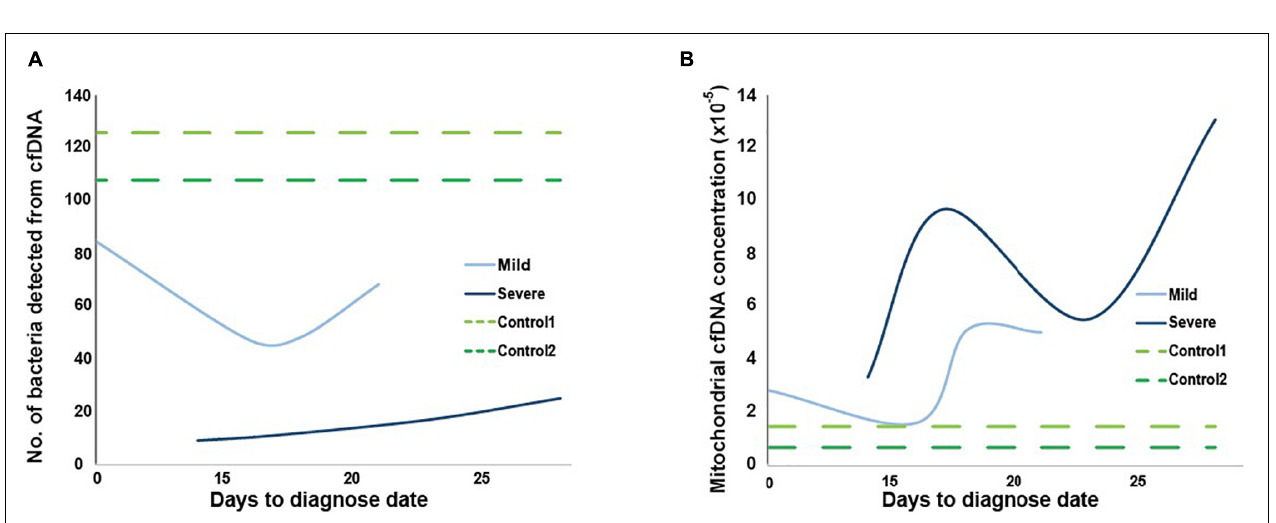
FIGURE 5 | Enriched pathways of genes with consistent alteration of gene expressions in both plasma and tissues. Enriched pathways of genes with consistent down- in panel (A) and upregulated pattern in panel (B) in plasma of severe patient and blood cells of COVID-19 patients. Enriched pathways of genes with consistent down- in panel (C) and upregulated pattern in panel (D) in plasma of severe patient and lung cells with SARS-CoV-2 infection.